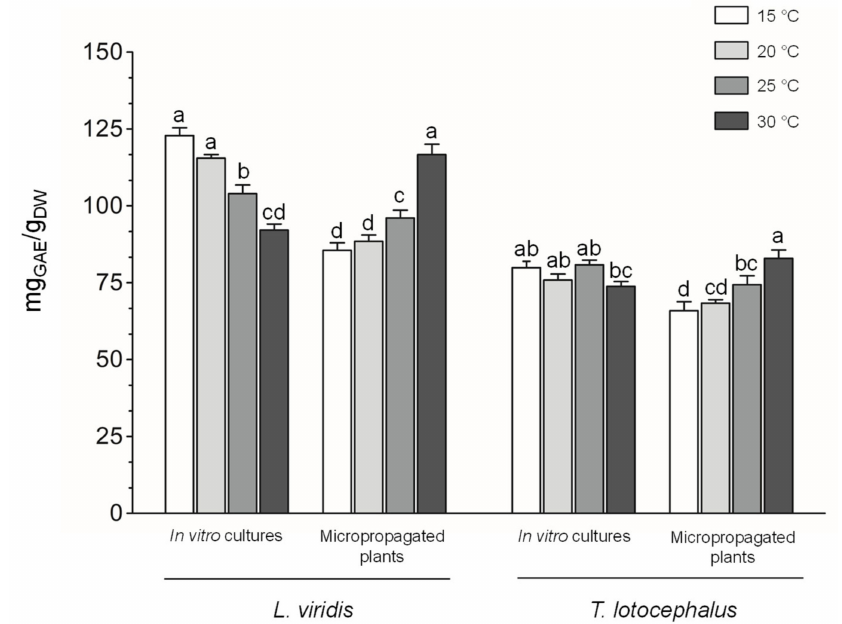
Figure 2. Effect of exposure to different temperatures (15, 20, 25, and 30 ◦ C) on total phenolic content determined by F-C method of in vitro cultures and micropropagated plants of Lavandula viridis and Thymus lotocephalus . For each species, the results were analyzed by one-way analysis of variance (ANOVA) and the graph bars followed by different letters (a–d) are significantly different at p < 0.05 (Duncan’s New Multiple Range